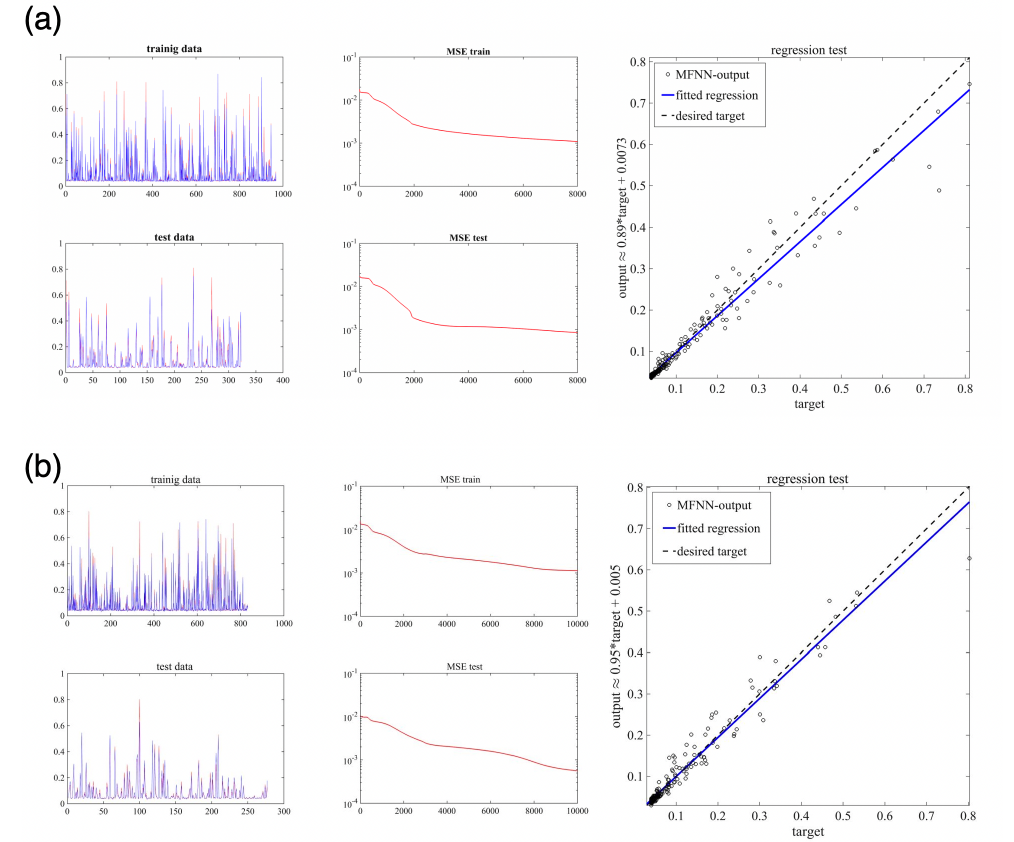
Figure 10. The performance of the MFNNs algorithm for Case4 ( a ) and Case5 ( b ). In the first column, the desired trajectories (shown in blue) are compared with the MFNN output (shown in red). In the second column, we have the relative MSE, and the regression test is given in the third